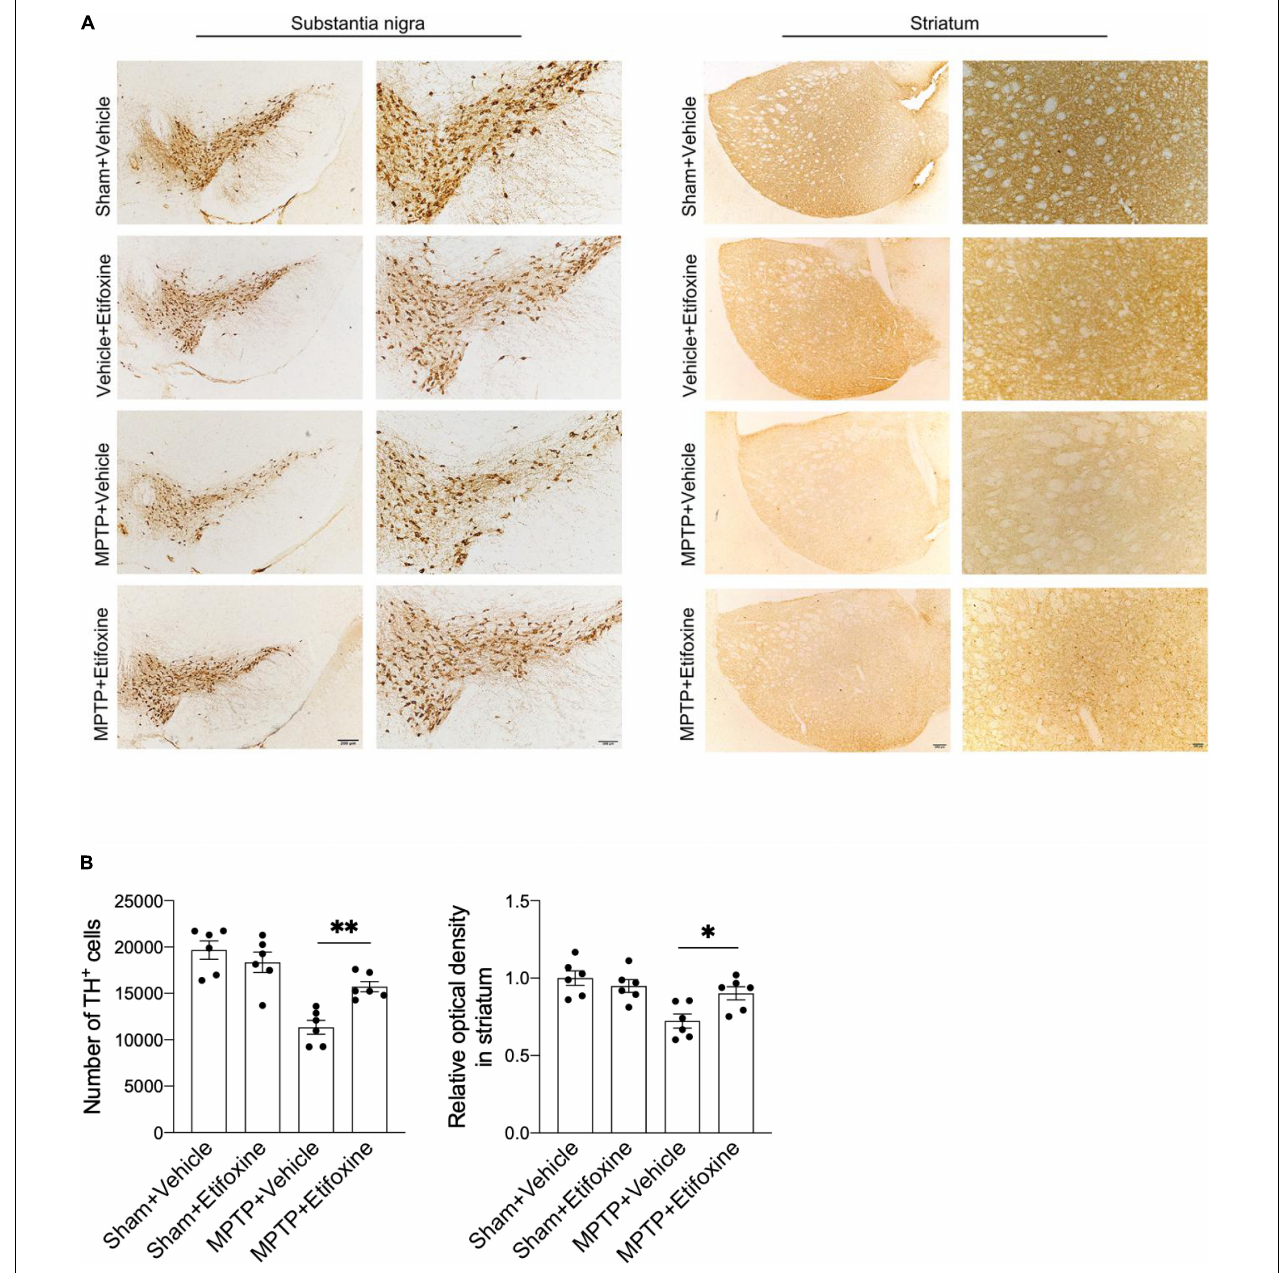
FIGURE 3 | Etifoxine decreased nigrostriatal dopaminergic neuron degeneration following MPTP treatment. (A) Immunostaining for TH showing TH + cells in the substantia nigra and TH immunoreactivity in the striata in C57BL/6 mice receiving etifoxine or vehicle on day 7 following saline or MPTP treatment. (B) Bar graphs showing the effects of etifoxine on the number of TH + cells in the substantia nigra and TH immunoreactivity in the striatum 7 days following vehicle or etifoxine treatment. F (3,20) = 17.88, P = 0.009 (Left); F (3,20) = 7.452, P = 0.04 (Right). All data are presented as means ± SEM. ( n = 6 mice per group) ∗ P < 0.05, ∗∗ P <